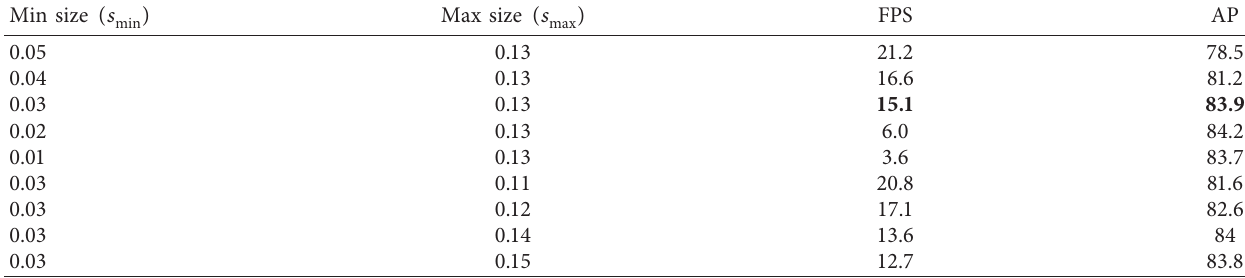
Table 3: Effects of min size and max size for default boxes on